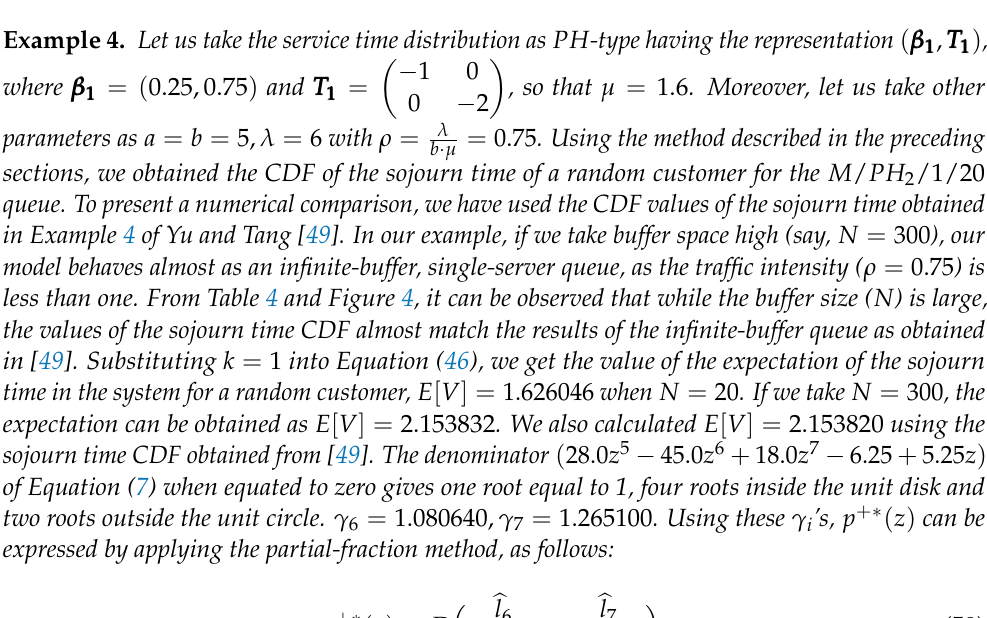
Figure 3. Effect of N on mean sojourn